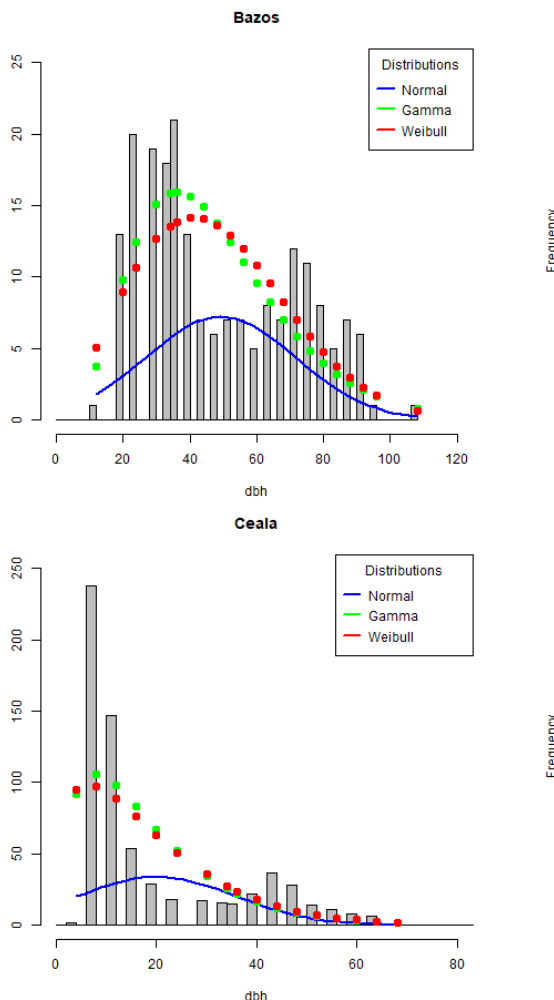
Table 2. Results of applying statistical tests to the experimental distribution of diameters.